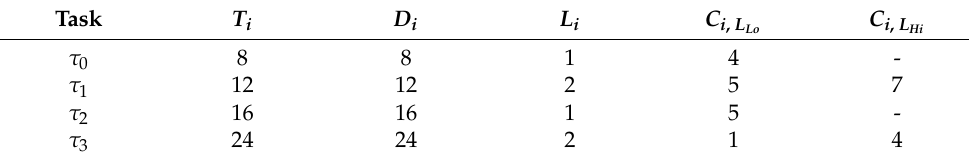
Table 1. Four-task set example.